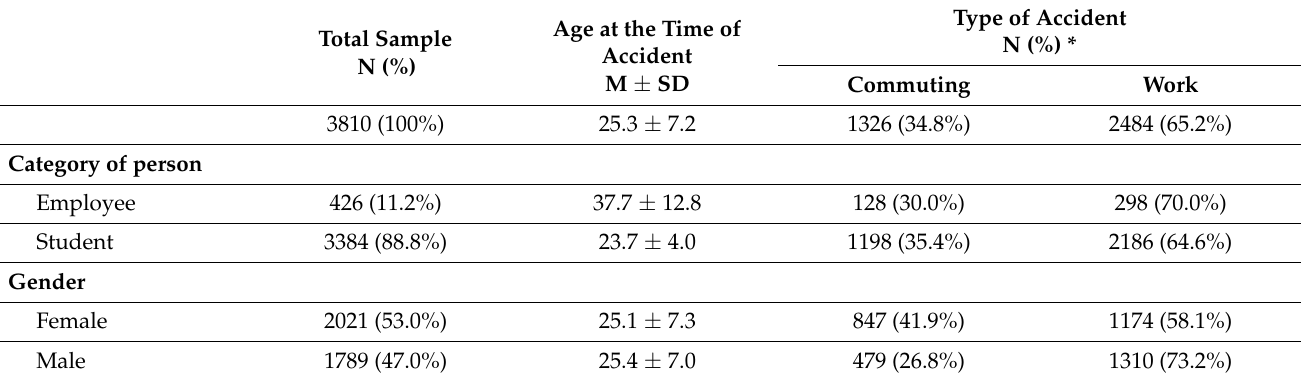
Table 1. Accident data and sample